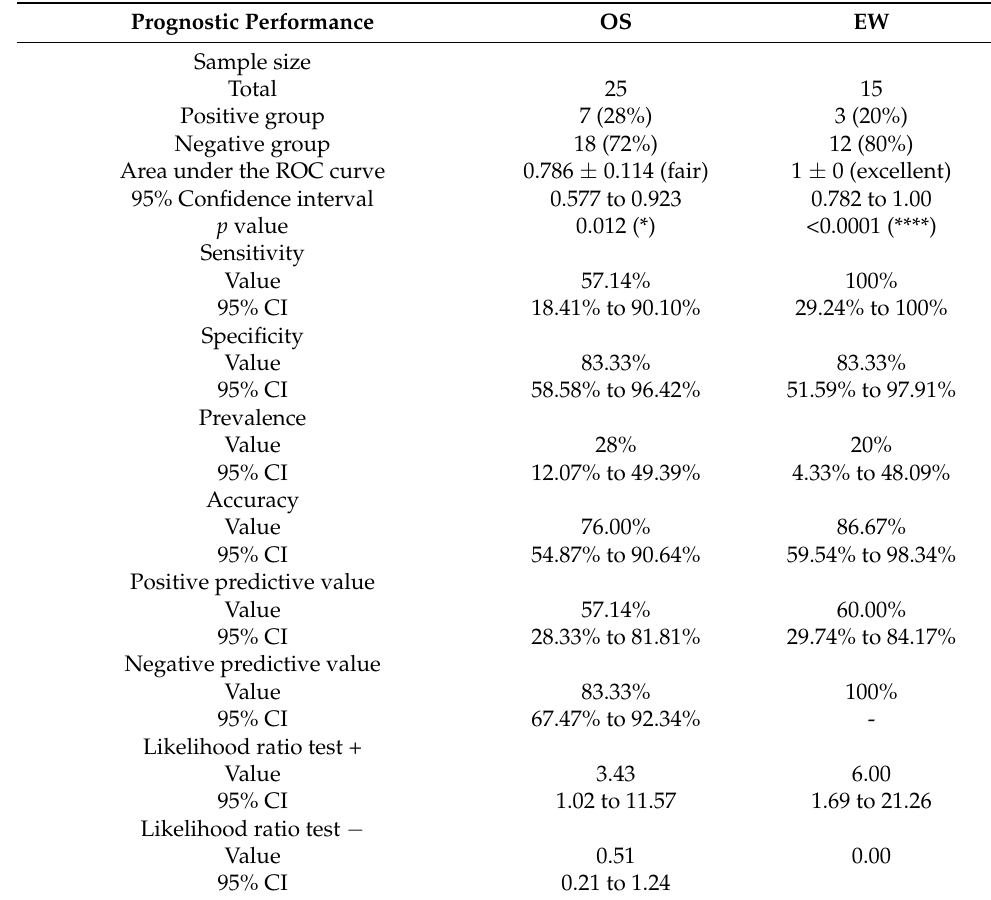
Table 2. ROC curve parameters and likelihood ratio test for the evaluation of the predictive per- formance of bone loss, as measured by QCT ( ∆ T0–T1 ), for low probability of long-term bone health recovery in patients with OS and EW, at 4 years (* p < 0.05, **** p < 0.0001). Prognostic Performance OS EW Sample size Total 25 Positive group Negative